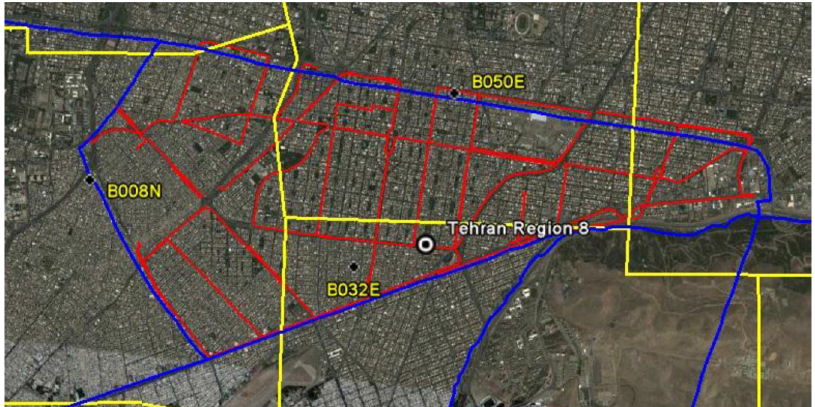
Figure 12. Drive test route map according to the division of urban areas and the border between base controller stations. The blue lines illustrate the 8 urban areas, the yellow lines illustrate the border between the base control stations, and the red lines illustrate the drive test route.